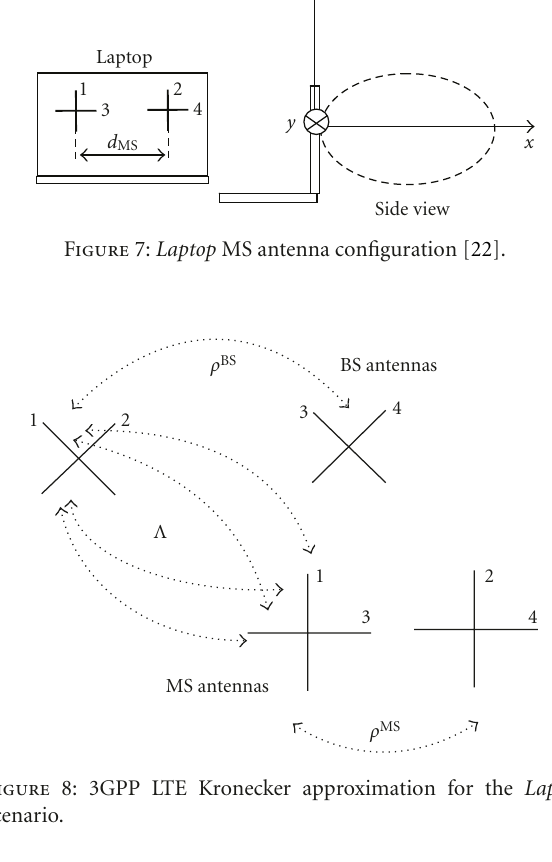
Table 3: Reference antenna configurations.